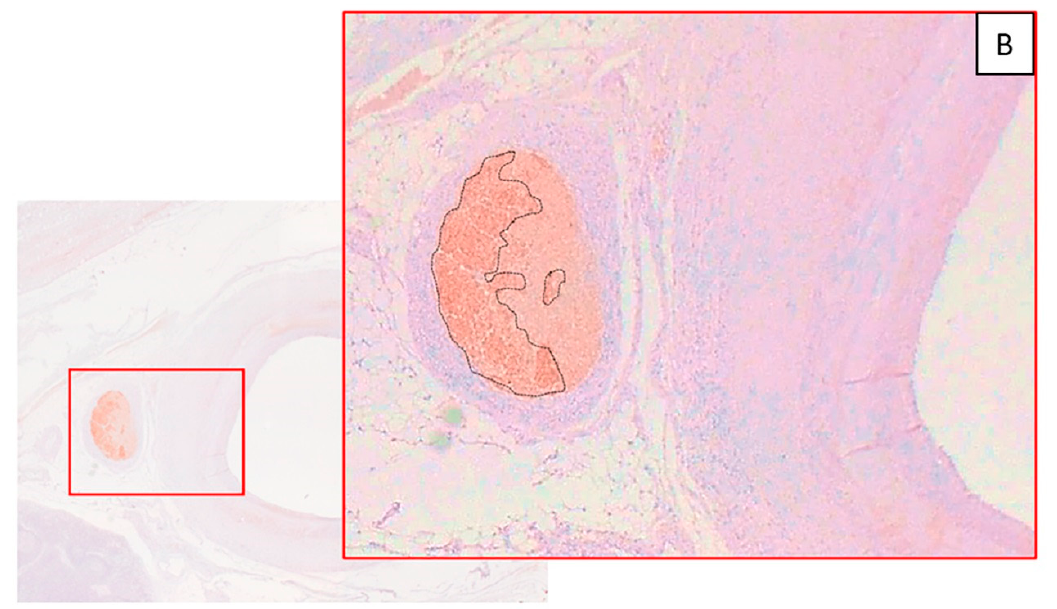
Figure 6. The images show representative images of the immunohistochemical staining with tyrosine hydroxylase (TH). ( A ) Three different types of affection following radiofrequency ablation. The clear arrow shows a nerve that has not yet been ablated at that level. The solid arrow shows evidence of a proximally ablated nerve displaying low TH staining demonstrating nerve atrophy. However, the nerve labeled with an asterisk shows how because of the nerve network, heterogeneous staining is displayed around some nerves with patches of strong TH staining combined with atrophied fibers.